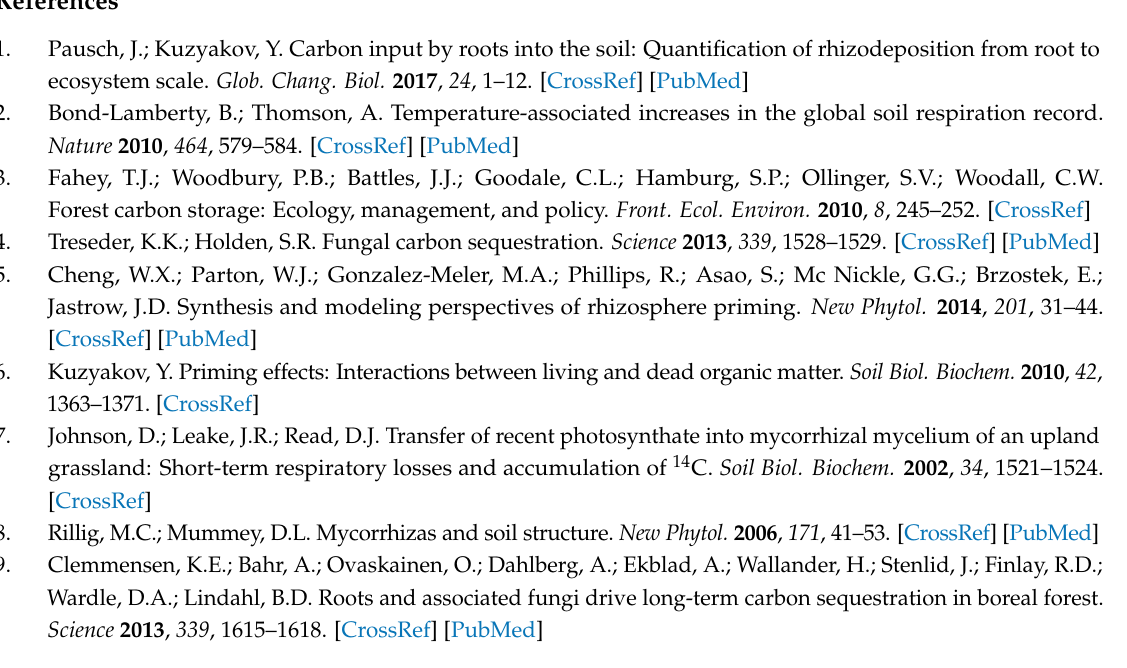
Figure S1: Experimental devices for